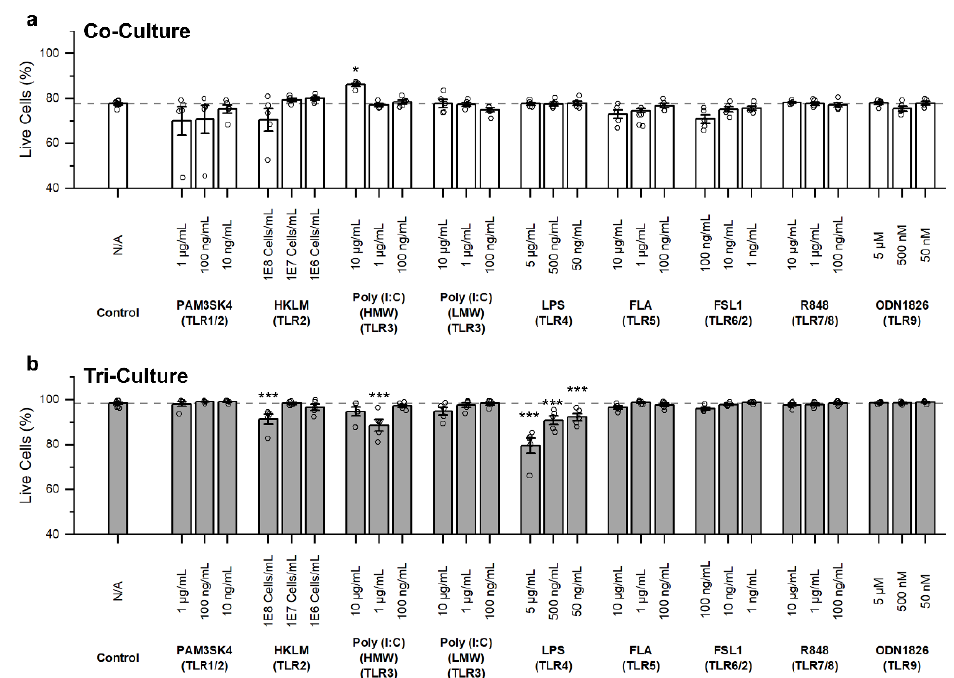
Figure 2. Influence of TLR agonist treatment on cell death as quantified by staining the cultures with Hoechst 33342 (Live) and propidium iodide (Dead). The overall percentage of live cells in ( a ) co-cultures and ( b ) tri-cultures following TLR agonist treatment. Data shown as mean ± SEM (n = 6 wells from two independent dissections) with individual data points plotted, * p < 0.05, *** p < 0.001 (as determined by a one- way ANOVA followed by Dunnett’s test vs . vehicle control).